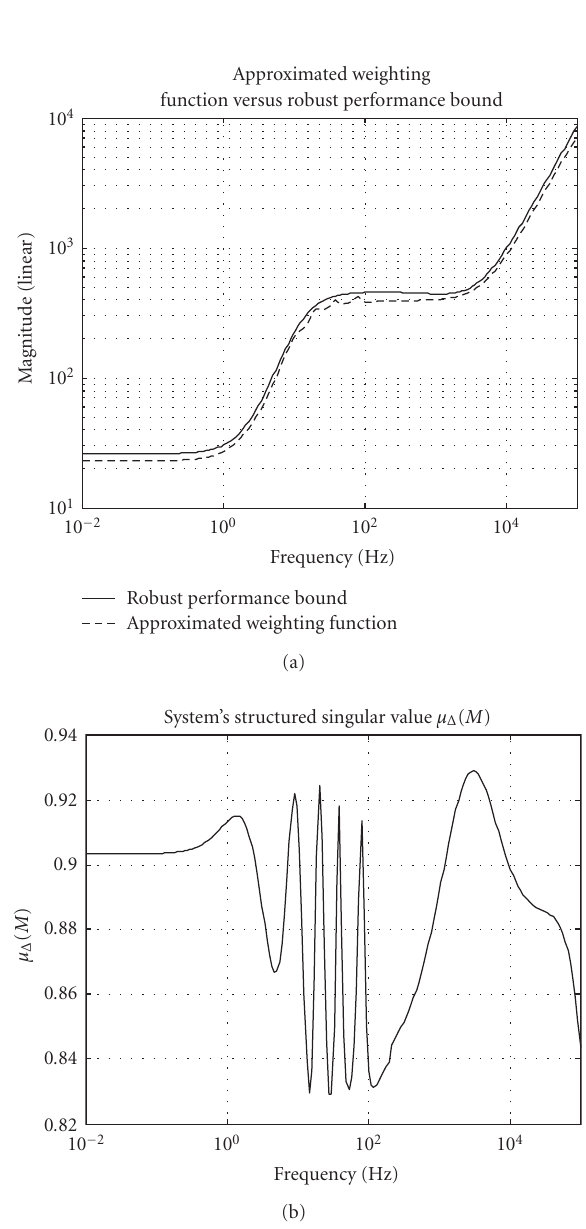
Figure 6: (a) The robust performance bound and the approximated weighting function W K , (b) with its respective structured singular value